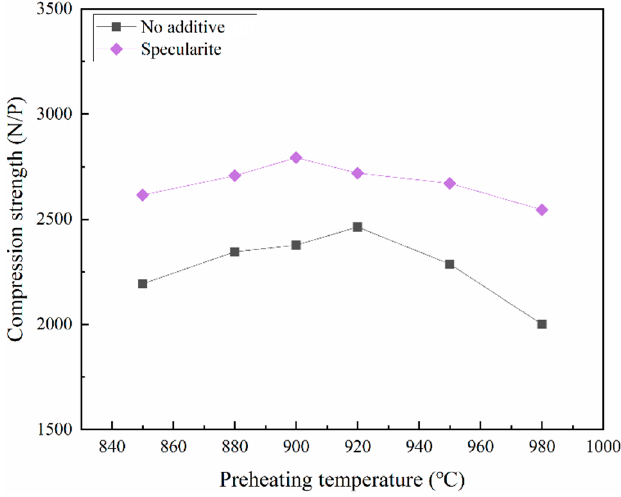
Figure 4. Effects of preheating temperature on compression strength of roasted pellets (preheating time 16 min, roasting temperature 1080 °C, roasting time 10 min).